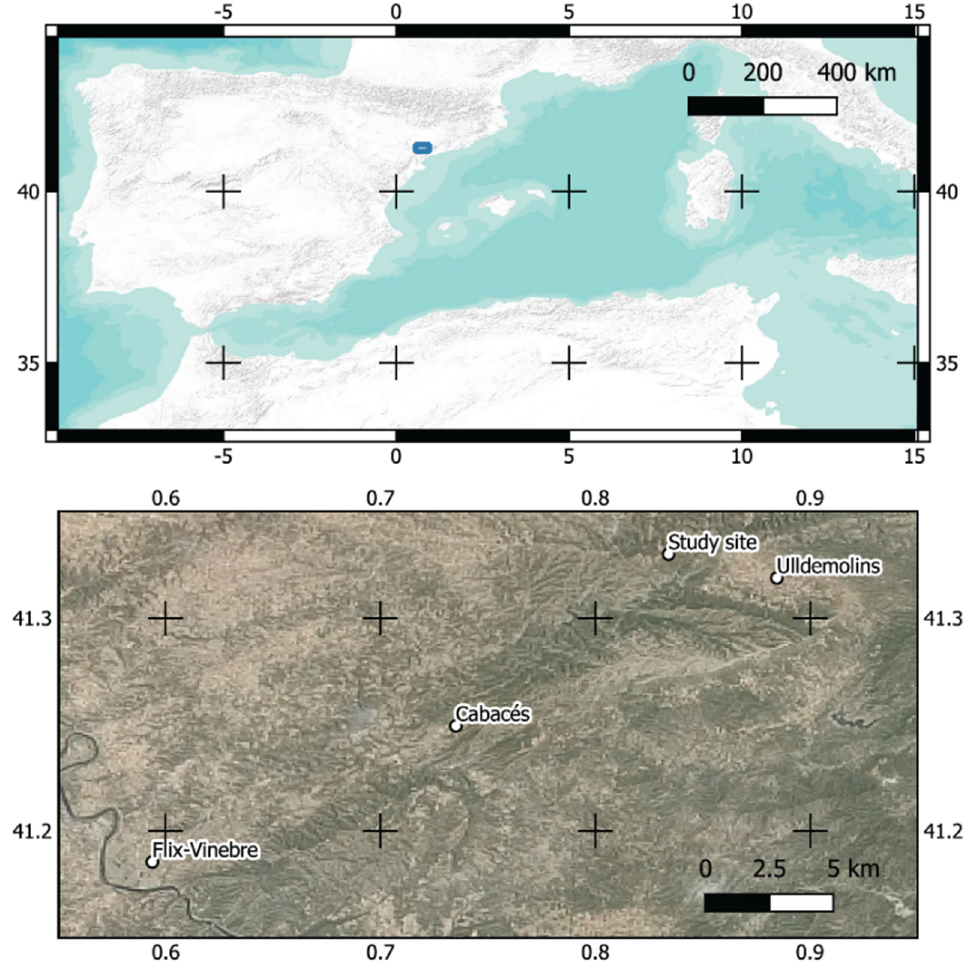
Figure 1. Location of the study site and the meteorological stations used in this study. Map developed with QGIS 3.18.2-Zürich (https://qgis.org/es/site/, accessed on 20 December 2021). Background: ESRI Terrain (© OpenStreetMap contributors, https://www.openstreetmap.org/copyright, accessed on 15 May 2021) ( upper panel ); 2012 orthophotography from the public map server IGN-PNOA WMS (https://pnoa.ign.es, accessed on 15 May 2021; OrtoPNOA 2012 CC-BY 4.0 scne.es) ( lower panel ). Table 1. Annual and seasonal values of mean temperature and precipitation during the long- term reference period (1970–2019) and the two decades considered in this study: wet